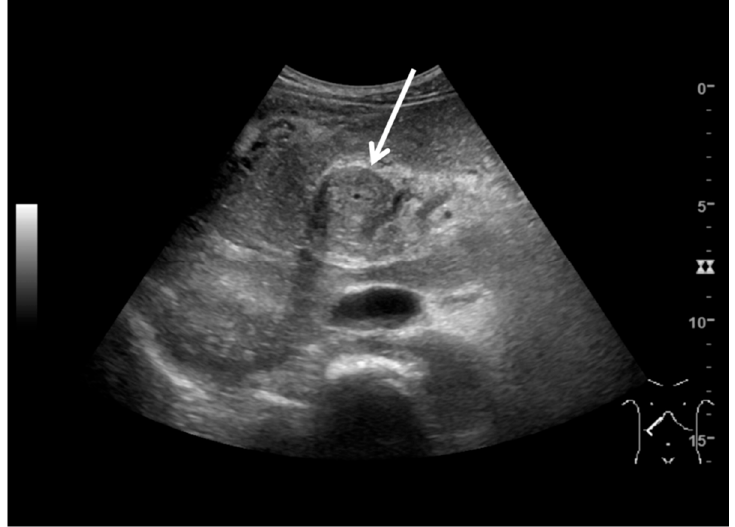
Figure 1. Ultrasound image of the abdominal mass (5.9 × 8.7 cm; arrow) in the right upper quadrant, surrounding the common bile duct.